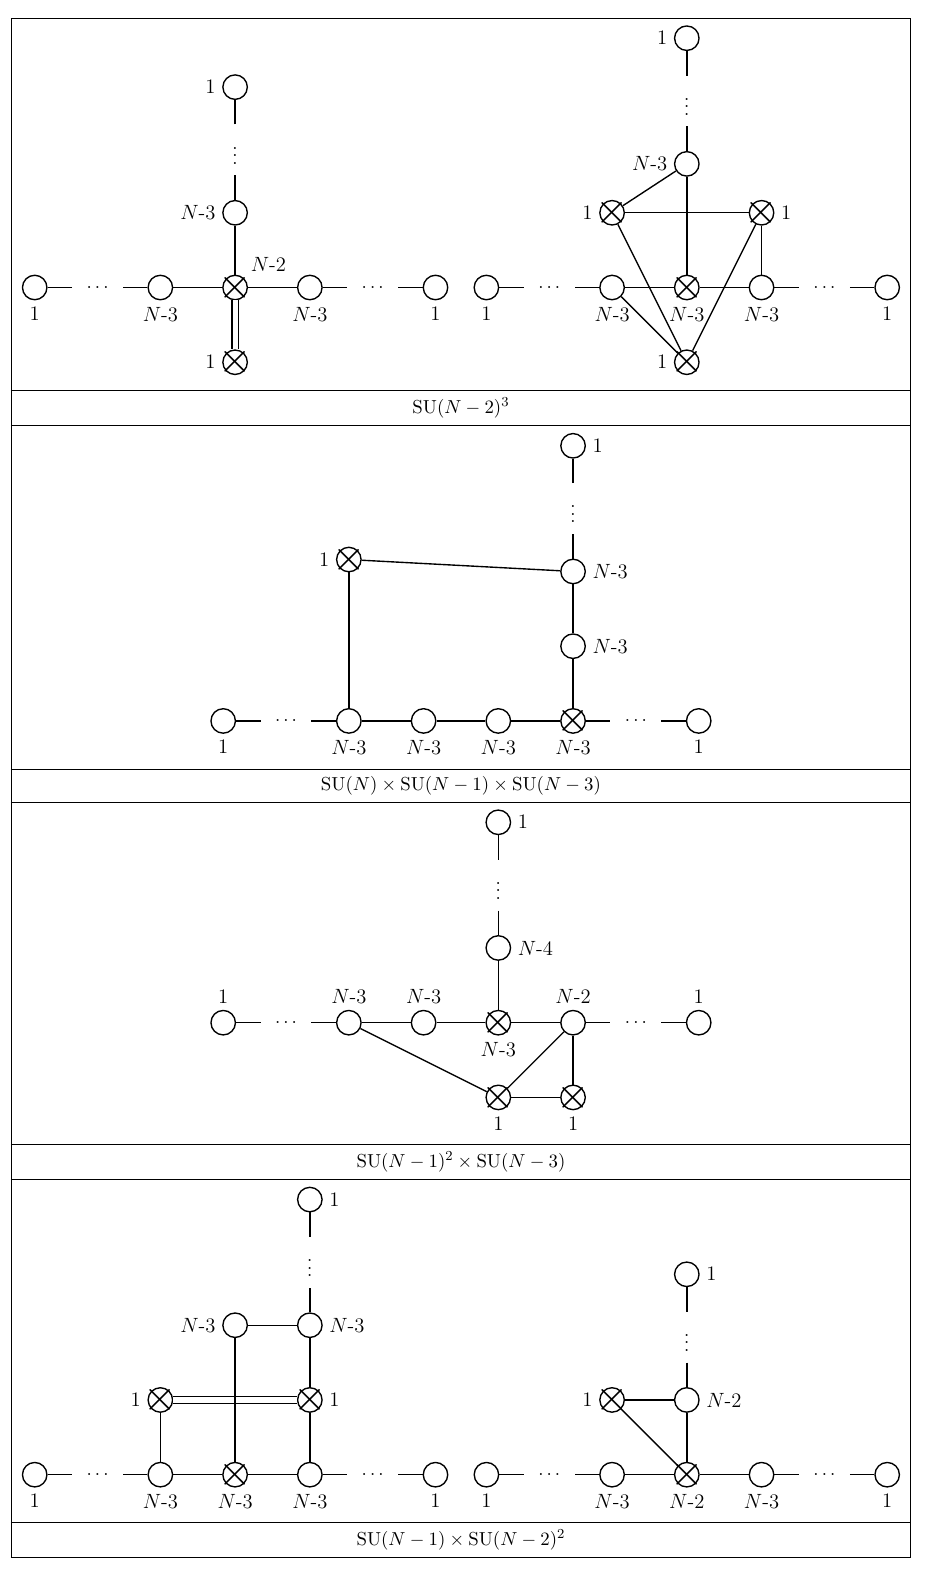
Table 3 . MQs for third descendants of T N> 3 with corresponding (cid:13)avor group.